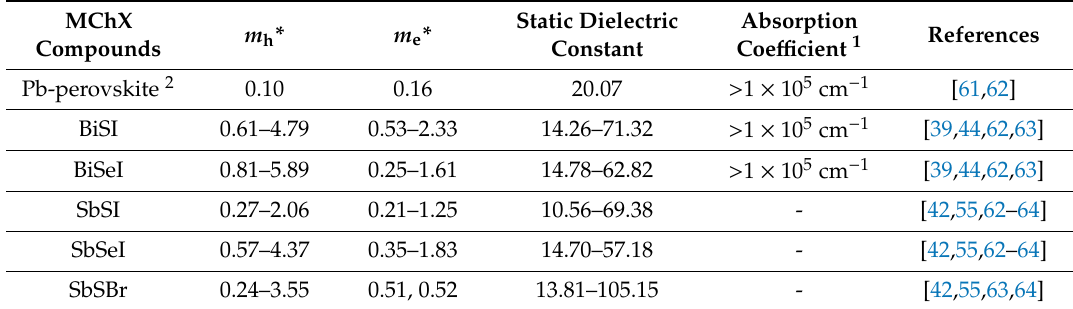
Table 3. Summary of e ff ective masses of hole ( m h *) and electron ( m e *), static dielectric constant, and absorption coe ffi cient of MChX family, calculated by di ff erent methods.